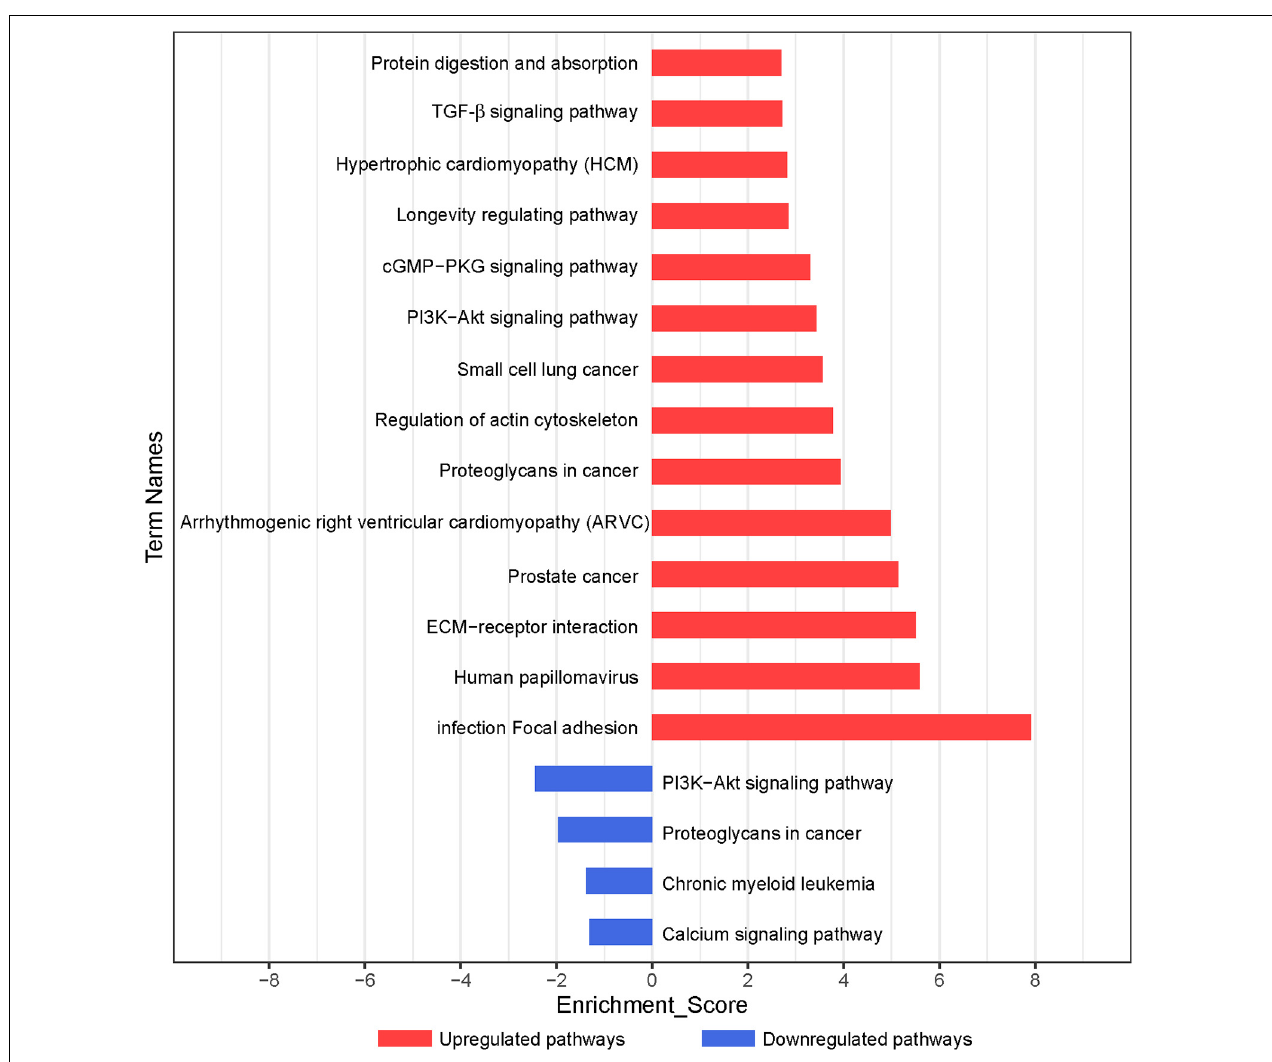
FIGURE 3 | Pathway analysis of differentially expressed genes during chondrogenic differentiation. Significant KEGG pathways are represented on the y -axis. –LgP, negative logarithm of the p -value, are represented on the x -axis. Larger –LgP displays a smaller p